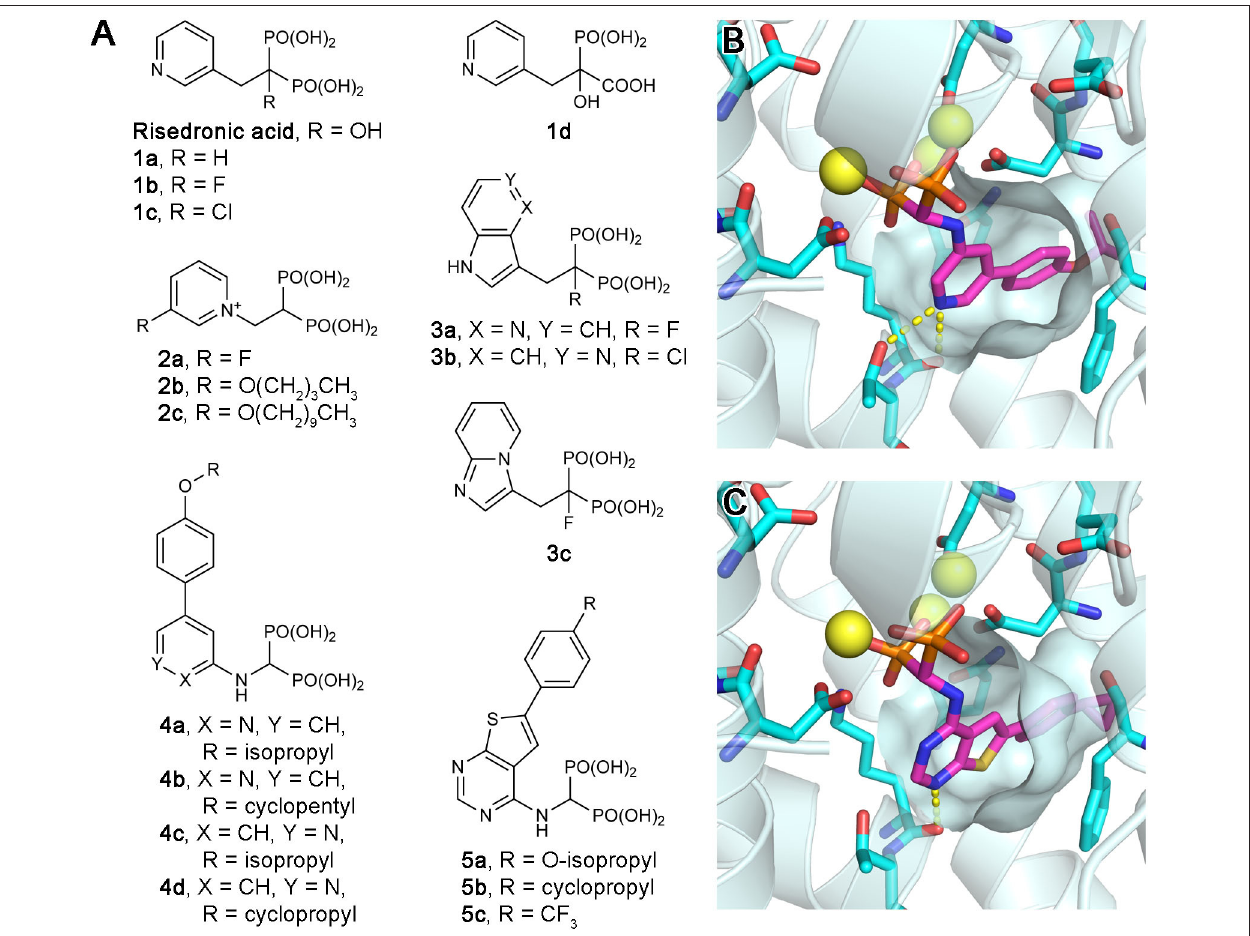
FIGURE 5 | Exploratory bisphosphonate inhibitors of human FPPS. (A) Molecular structures of exploratory bisphosphonate inhibitors of hFPPS. (B) The binding of inhibitor 4c (magenta; PDB ID: 4PVY). The residues of interest displayed as sticks are the same as in Figures 3B–D . (C) The binding of 5b (magenta; PDB ID: 4L2X).